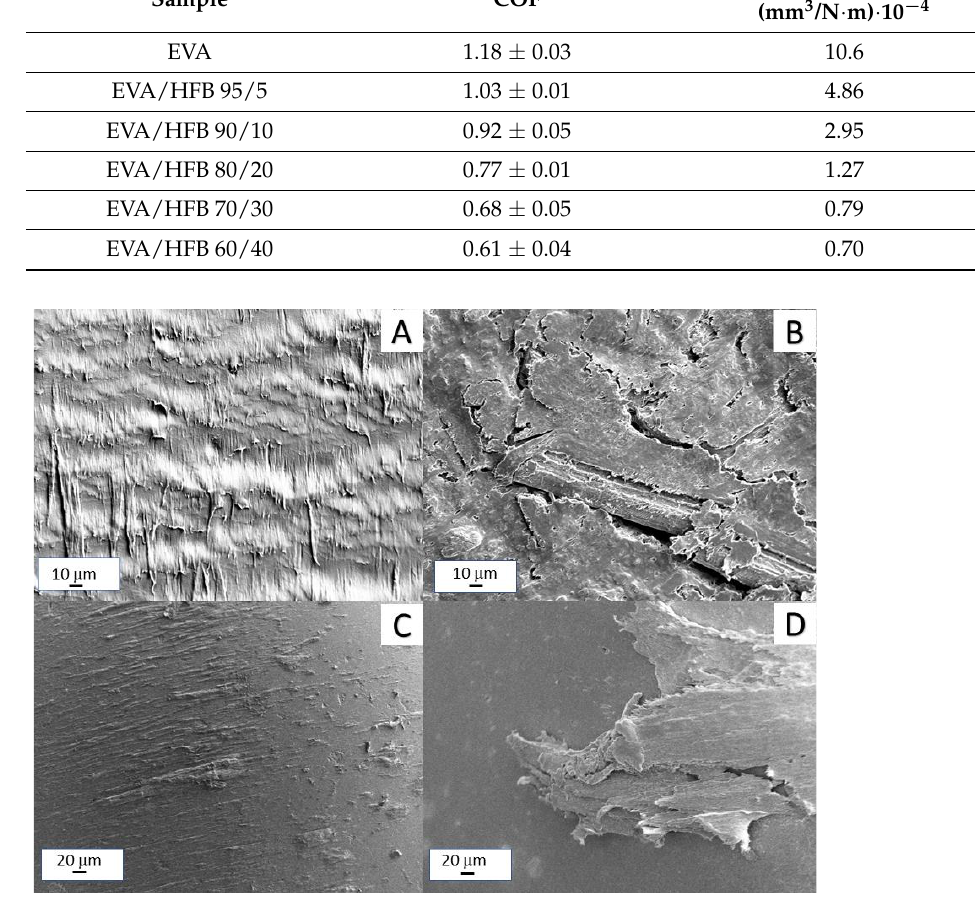
Figure 9. Topographical features of the surfaces of neat EVA ( A ); EVA/HFB 80/20 ( B ); alumina ball after sliding tests against neat EVA ( C ); alumina ball after sliding tests against EVA/HFB 60/40 composite ( D ).